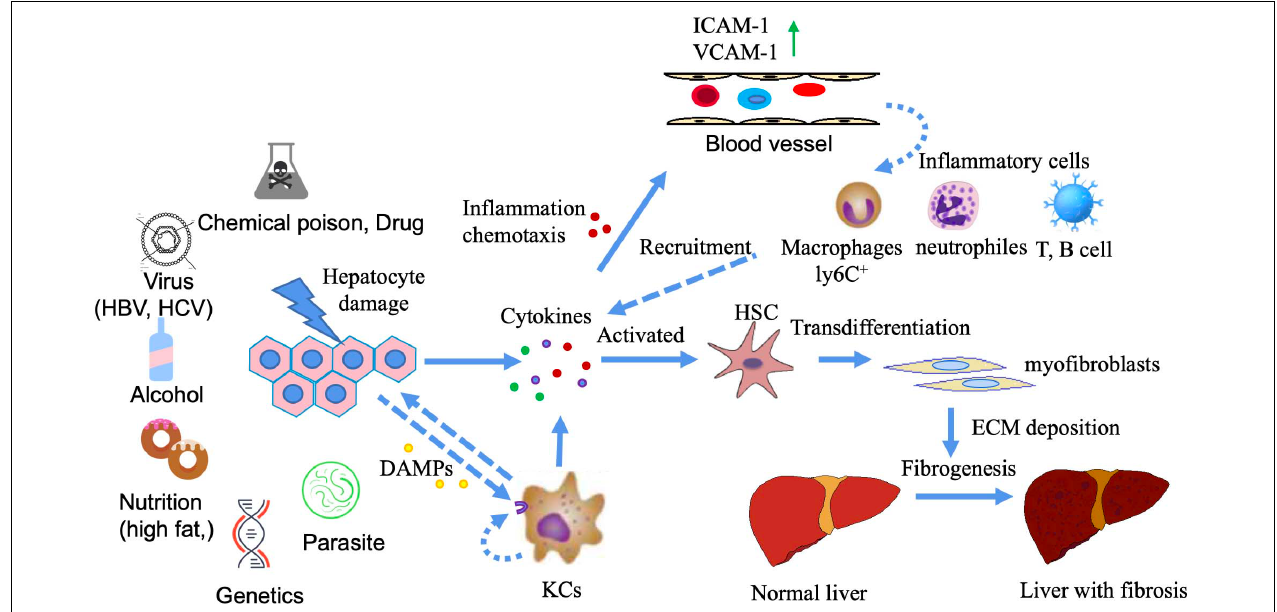
FIGURE 1 | The mechanism of liver fibrosis. Liver damage can be caused by a variety of factors (e.g., chemical poisons, viruses, alcohol, nutrition, genetics, parasites, etc.). Injuries of liver cells release a variety of cytokines, among which damage-associated molecular patterns(DAMPs) (such as S100 family, high mobility group protein, etc.) can activate Kuffers (KCs) cells to produce inflammatory cytokines. Inflammatory cytokines can play a role through autocrine and paracrine. At this point, vascular permeability at the injured site increases, vascular endothelium simultaneously expresses high adhesion molecules, and inflammatory cells in the blood chemotaxis to the injured site under the action of chemokines, leading to the occurrence of inflammation. Multiple cytokines produced at the site of liver injury activate resting HSCs, causing HSCs to differentiate into myofibroblasts and produce ECM deposition. If the injury and inflammation are persistent or recurring, the deposition of ECM cannot be reversed, leading to liver